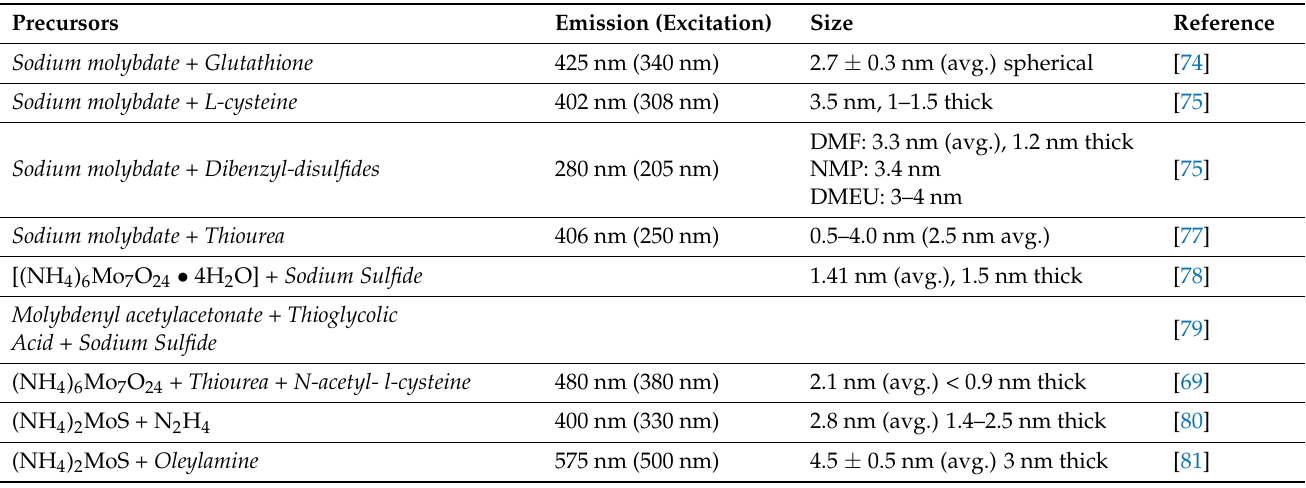
Table 2. Hydrothermal synthesis of MoS 2 quantum dots with various